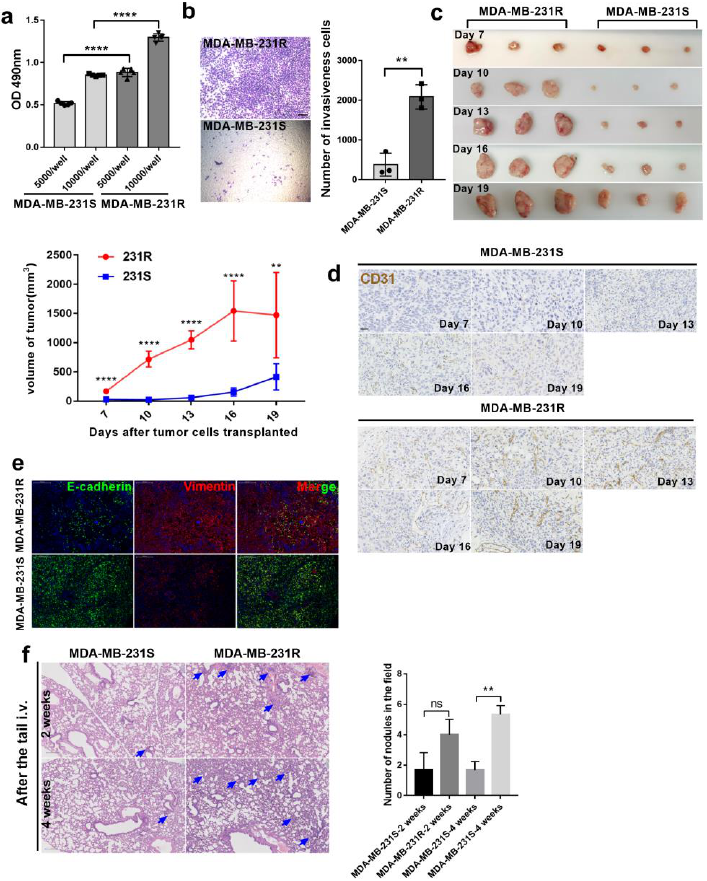
Figure 1. Evaluation of bevacizumab resistance model. ( a ) Different number of MDA-MB-231-S/R were seeded in 96-well-plate and cell survival was measured by MTT after 48 h. (MDA-MB-231-S, bevacizumab sensitive MDA-MB-231 cell; MDA-MB-231-R, bevacizumab resistant MDA-MB-231 cell), ****, p < 0.0001, t -test. Error bars represent SD. ( b ) The number of invaded cells in each group. n = 3. ** p < 0.01 by t test. Error bars represent SD; each transwell assay was independently repeated three times; scale bar, 100 µ m. ( c ) Tumor growth volume and photos over time following subcutaneous transplant of MDA-MB-231-S/R tumor tissues into nude-balb/c mice. n = 15 for each condition. ** p < 0.01; **** p < 0.0001 by two-way ANOVA test. ( d ) Representative images of tumor sections from two groups treated with bevacizumab at different time points, Scale bar, 200 µ m. ( e ) Representative images of tumor sections from mice treated with bevacizumab. Vimentin was co-stained with E- cadherin and nucleus. Scale bar, 200 µ m. ( f ) Representative images and statistical analysis of HE staining to assess the number of lung metastasis in the different treatment groups; scale bar, 100 µ m, ** p < 0.01 by t